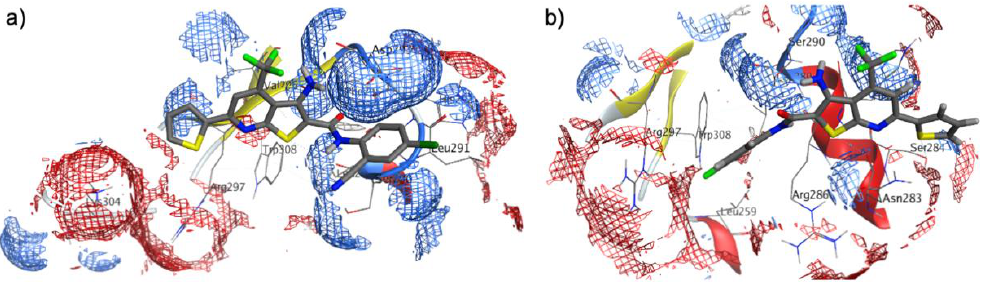
Figure 9. FOXM1 MEP and its interaction with compounds ( a ) 6 and ( b ) FDI-6 . Electrostatic poten- tials are indicated by the red and blue meshes, with blue representing electronic-donor areas and red representing electronic-acceptor areas.